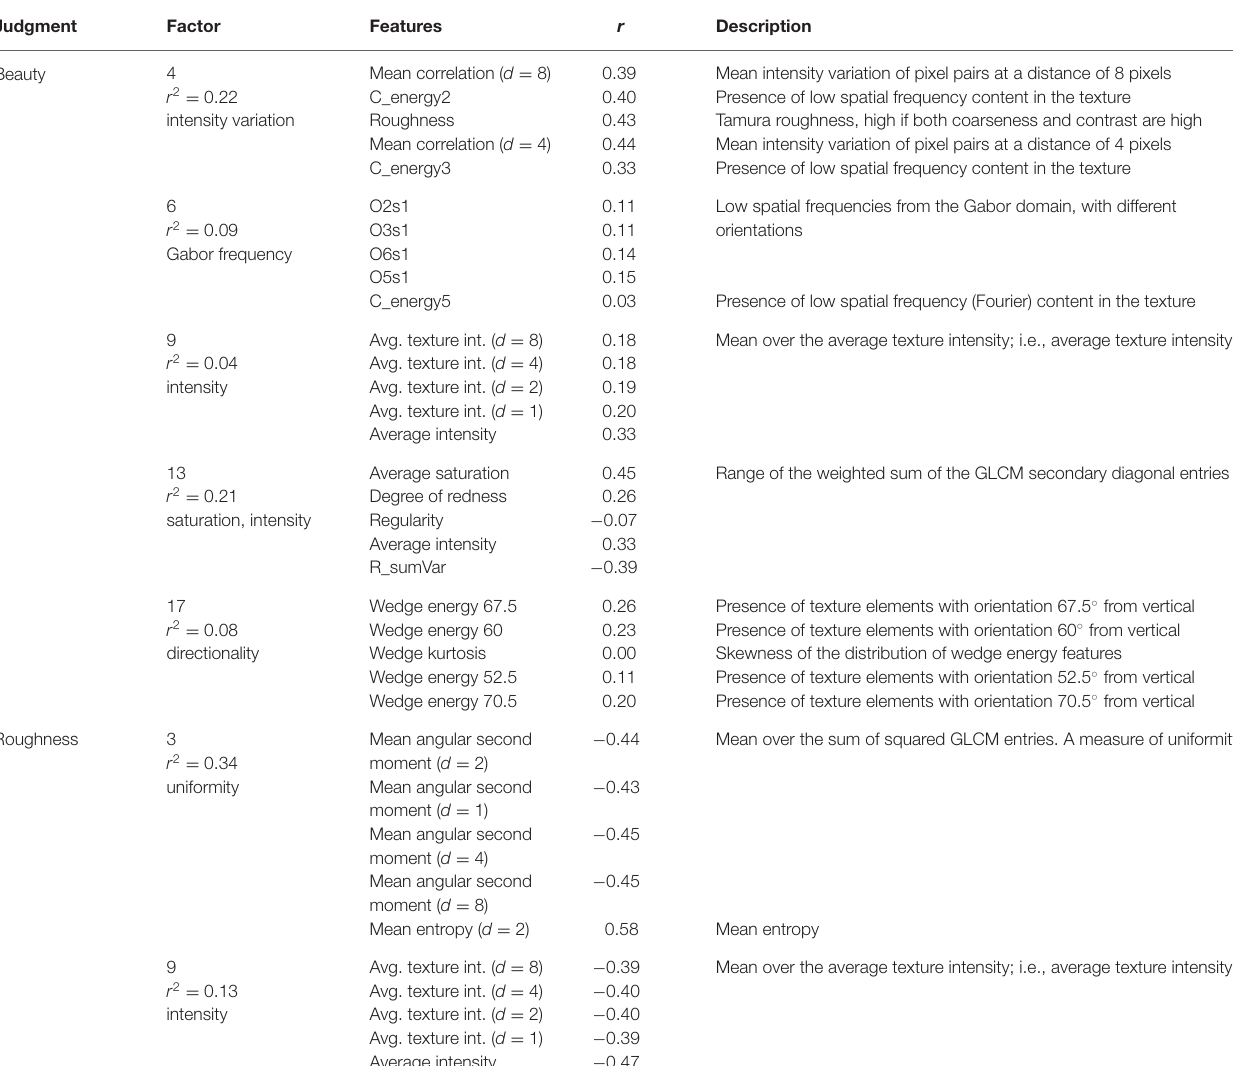
TABLE 2 | The feature factors that significantly correlated with beauty and roughness ratings and their constituent features.